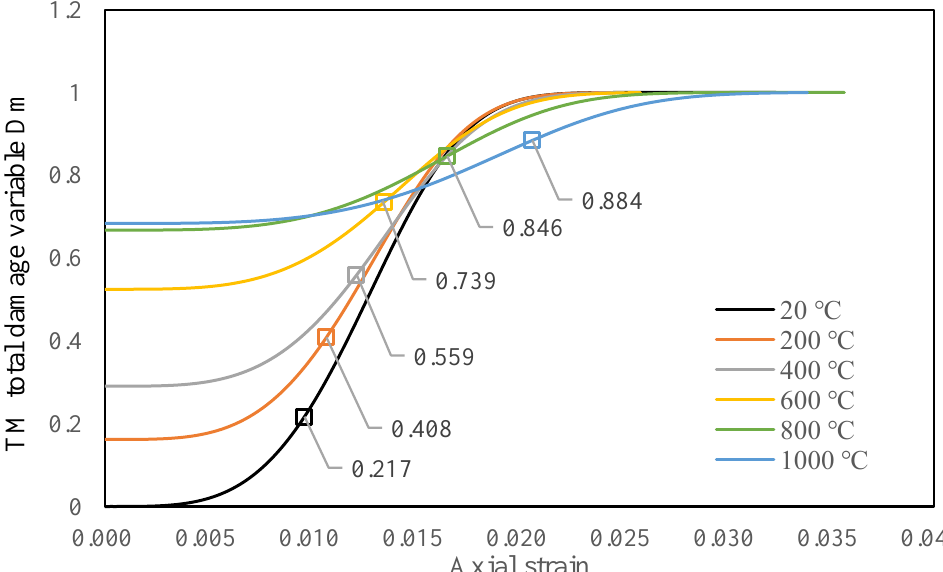
Figure 2. The average values of the damage variables of granite specimens exposed to different temperatures.